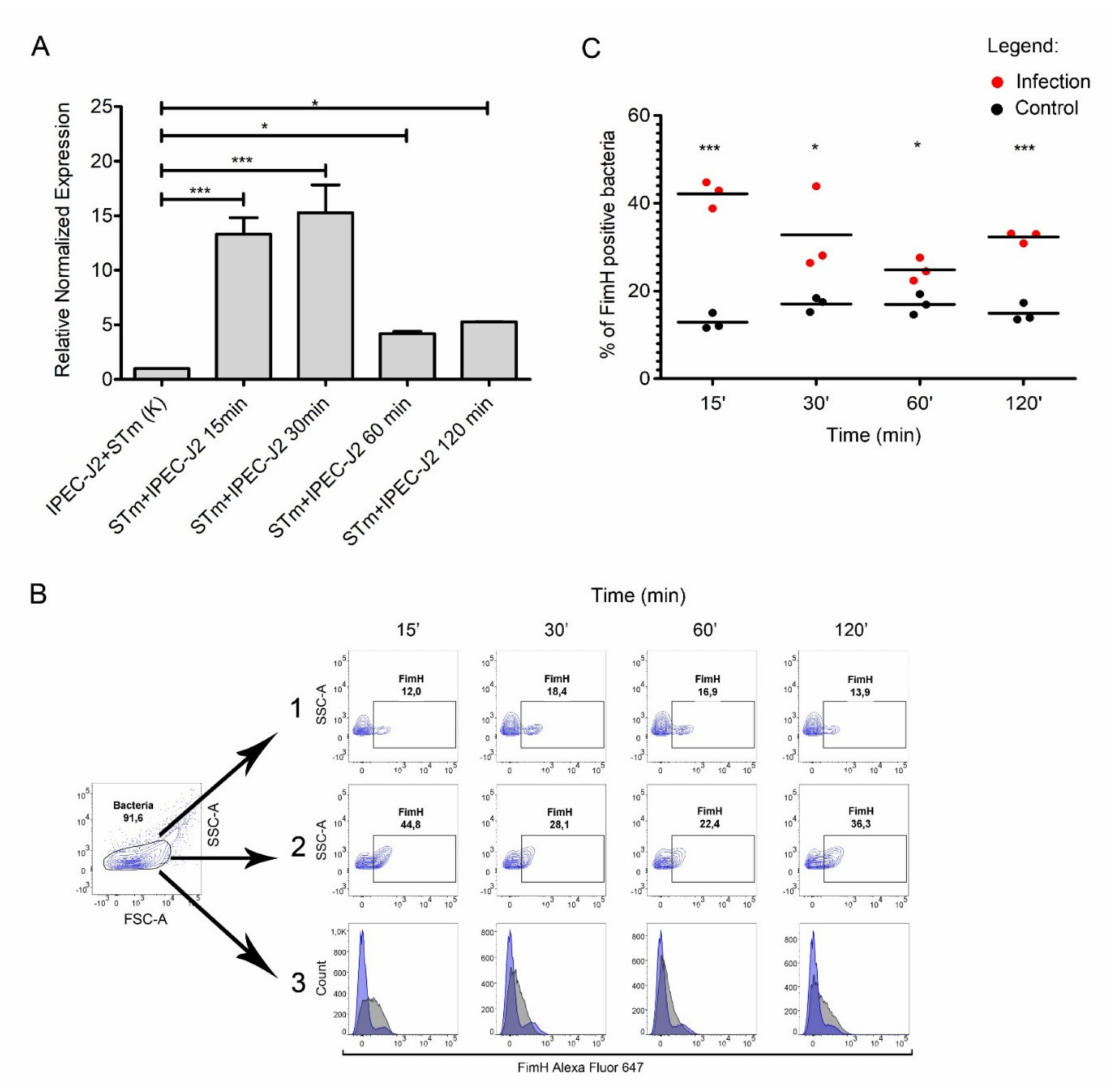
Figure 4. FimH expression during IPEC-J2 cells infection with Salmonella Typhimurium. ( A ) Relative expression of fimH mRNA in S. Typhimurium attached to IPEC-J2 cells at 0, 15, 30, 60, and 120 min after 1st passage. Data represent the mean ± SD of three independent experiments. Triplicate samples were analyzed in each experiment to confirm the accuracy and reproducibility of qPCR. Statistical di ff erences were analyzed using one-way ANOVA and are presented as means. ( B ) Representative dot plots for the gating strategy of FimH-positive S . Typhimurium. (1) Control bacteria S . Typhimurium in cell culture medium without IPEC-J2 cells in conditions mimicked those used for the cell infection experiments. (2) S. Typhimurium attached to IPEC-J2 cells at 0, 15, 30, 60, and 120 min (MOI 50) after the first passage. (3) Representative overlay histograms comparing the expression of FimH protein in S. Typhimurium attached to IPEC-J2 cells (grey histograms) and control bacteria (blue histograms). ( C ) Percentage of FimH-positive S. Typhimurium attached to IPEC-J2 cells or control bacteria at 0, 15, 30, 60, and 120 min after the first passage measured by flow cytometry. Data represent the three individual values and a mean from three independent experiments. Statistical di ff erences were analyzed by Student’s t -test and are presented as individual values with a mean. * p < 0.05, and *** p < 0.001. To investigate whether fimH transcription correlates with protein present on the bacterial cell surface, we measured FimH surface protein by flow cytometry over the duration of our adhesion assay with the IPEC-J2 cell line (Figure 4B). The number of FimH-positive cells was significantly higher in bacteria attached to IPEC-J2 cells compared to control samples at each time point. After 15, 30,